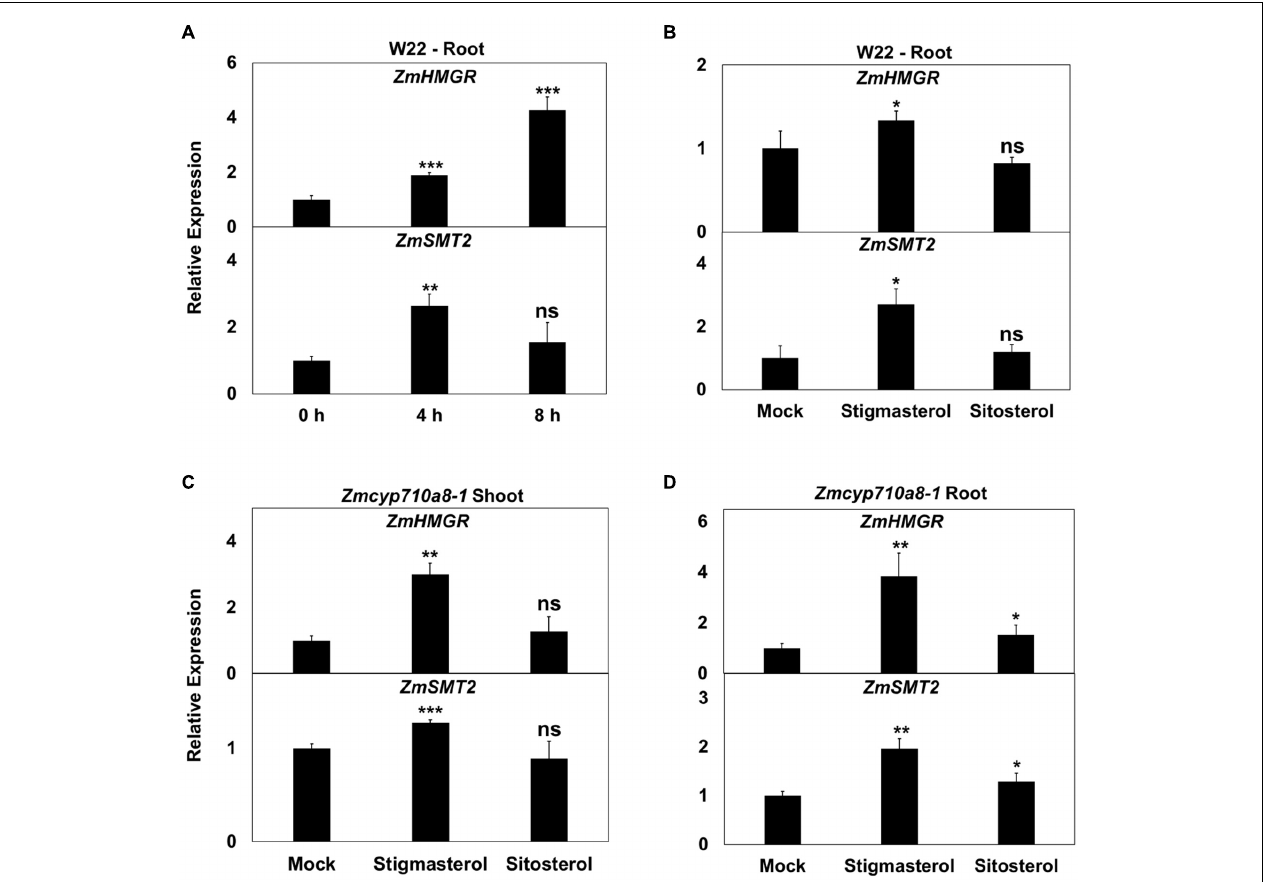
FIGURE 6 | Impact of exogenous stigmasterol on the expression of maize sterol biosynthesis genes. (A,B) Relative mRNA quantification of ZmHMGR and ZmSMT2 genes in wild type (W22) (A) in response to feeding 10 µ M stigmasterol at different time points, (B) in response to 10 µ M stigmasterol and 10 µ M sitosterol feeding for 4 h. (C,D) Relative mRNA quantification of ZmHMGR and ZmSMT2 genes in Zmcyp710a8-1 background in response to various sterols (10 µ M) for 4 h (C) in roots and (D) in shoots. ZmACTIN was used as a reference gene for normalization. Data are means ± SD. Asterisks indicate statistical significance by Students t -test compared to 0 h in panel (A) and to Mock in panels (B,C,D) . * P < 0.05; ** P < 0.01; *** P < 0.001; ns, not